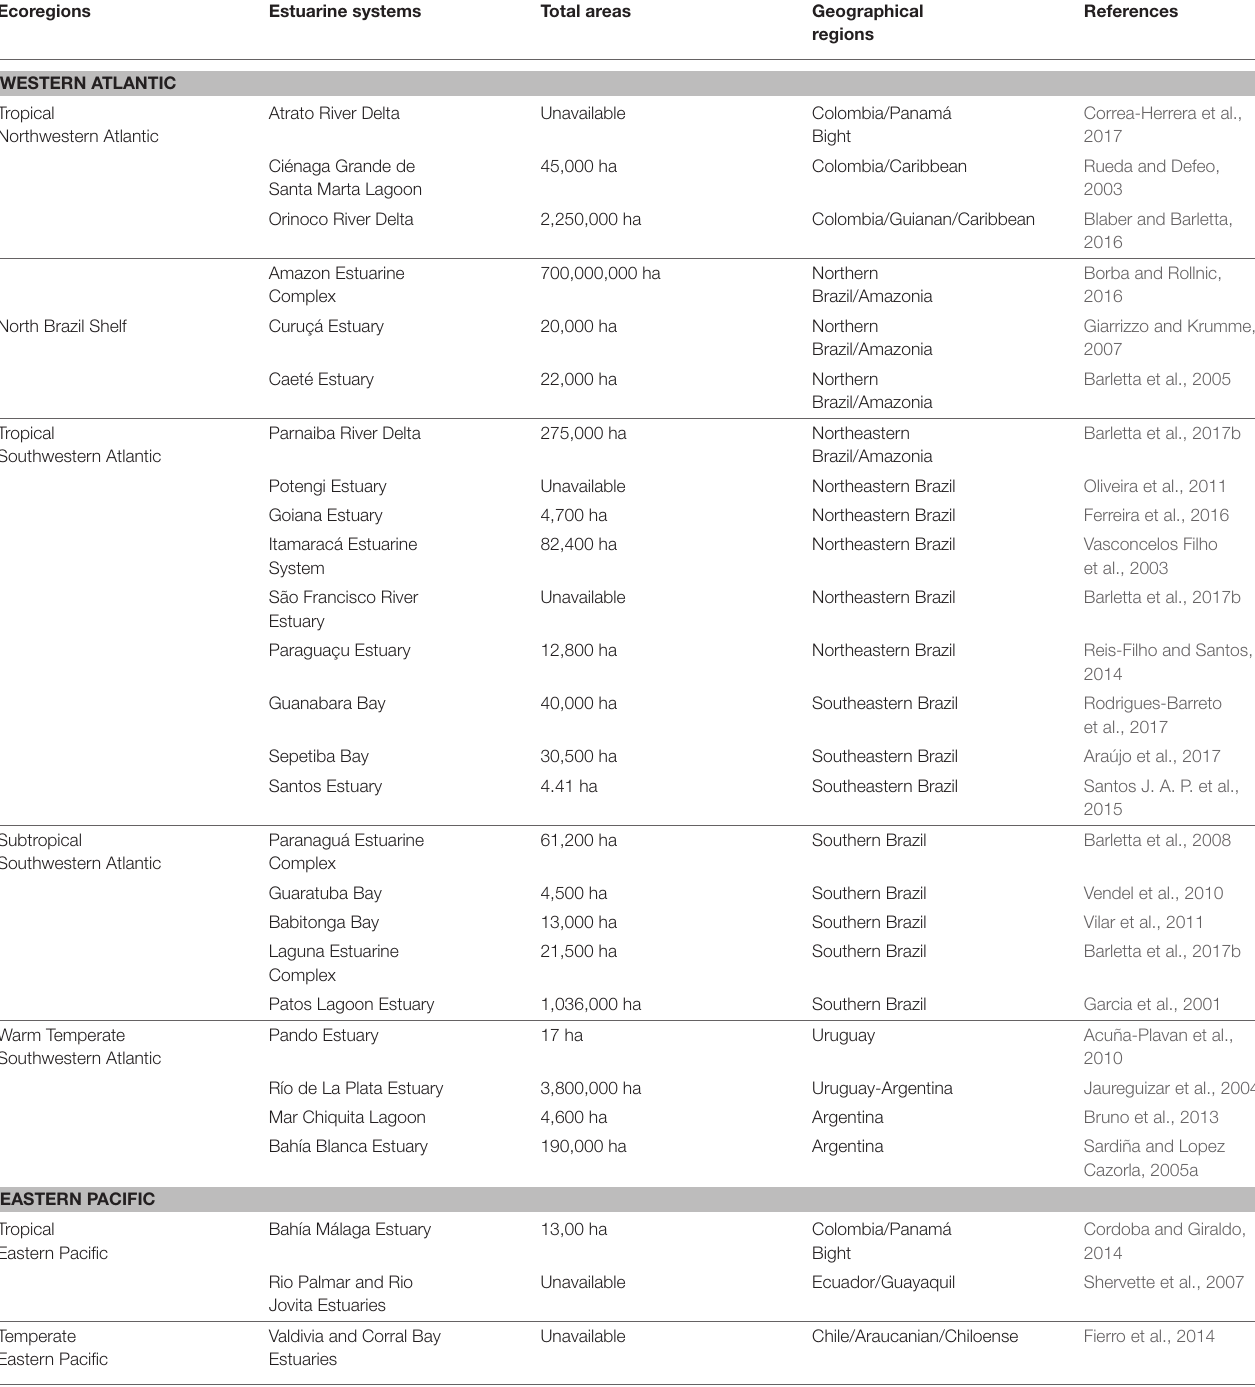
TABLE 1 | Ecoregions, geographical regions, and total area of key estuarine systems in South America based on available published